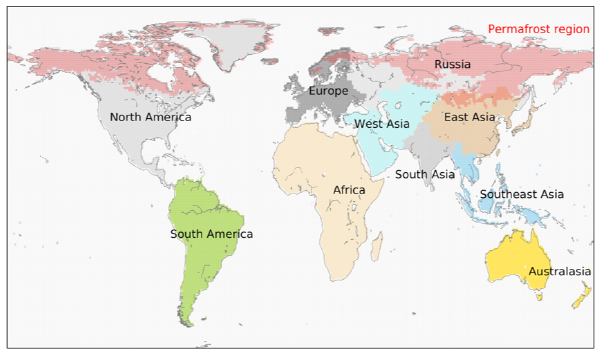
Figure 1. Map of the RECCAP2 regions. The “region” in red cor- responds to permafrost-covered areas. Map plot courtesy of Naveen Chandra